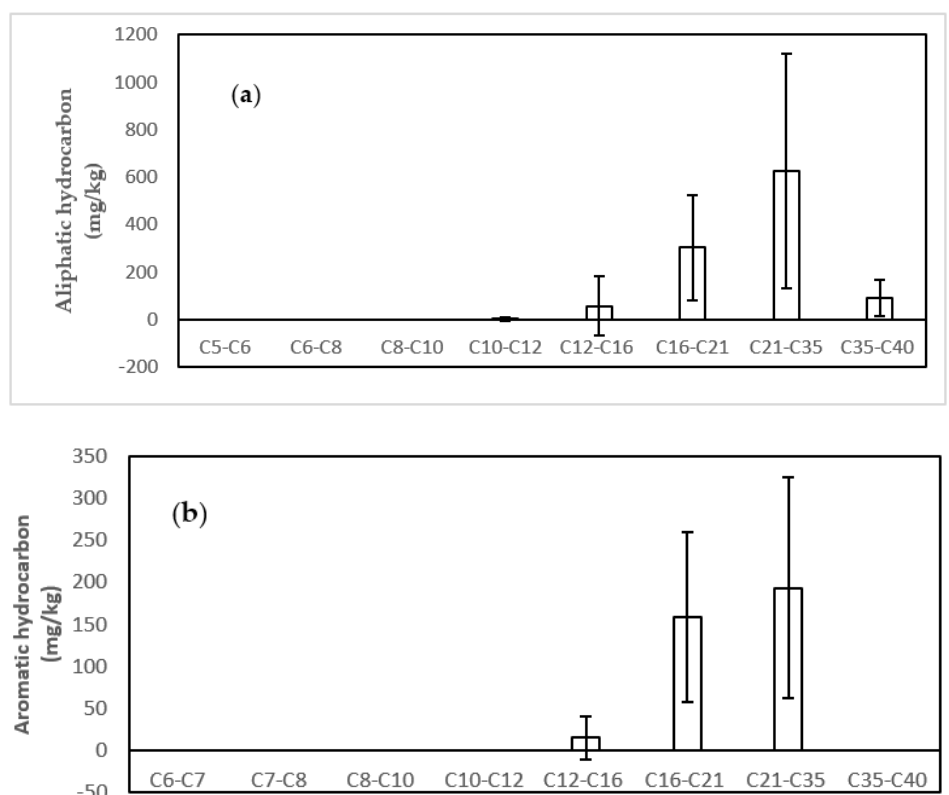
Figure 4. Distribution of various ( a ) aliphatic hydrocarbon fractions and ( b ) aromatic hydrocarbon fractions in the surface layer (0–5 cm) of the contaminated soil.